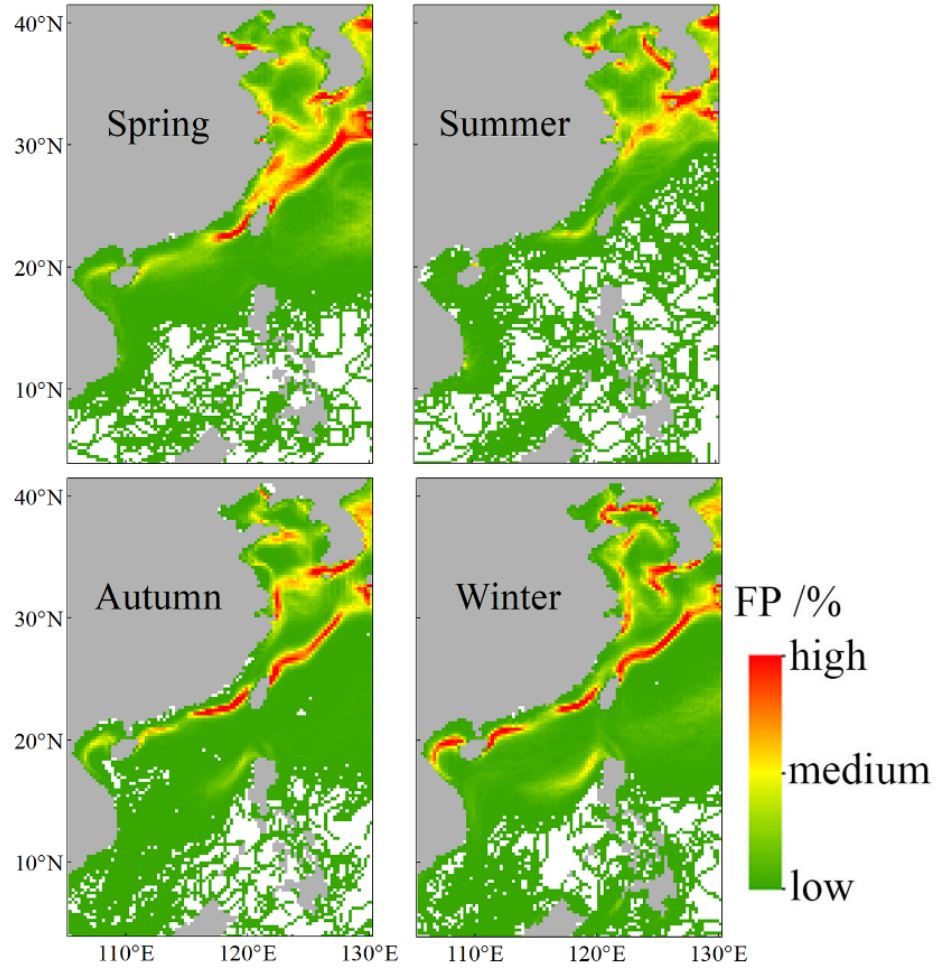
Figure 4. Seasonal frontal probability maps for 1982–2021.